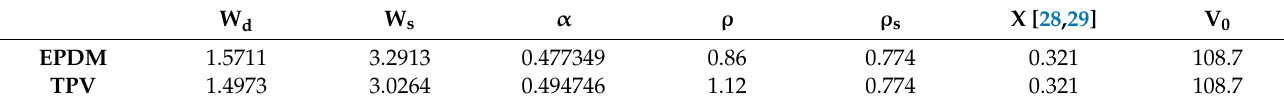
Table 1. Variable parameters of Flory–Rehner equation used in this study.